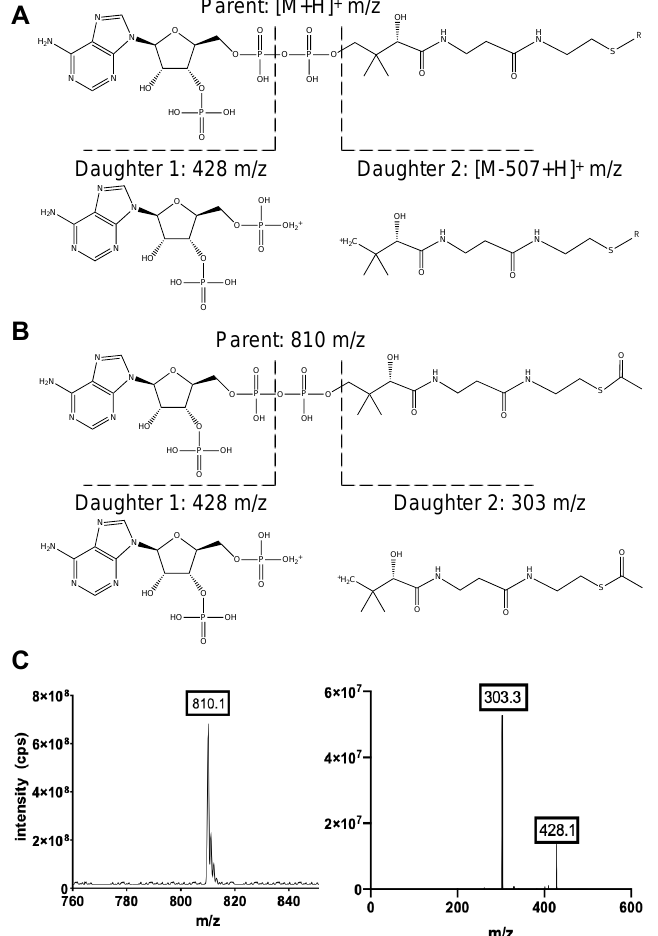
Figure 2. The common MS/MS fragmentation pattern for all CoA species: ( A ) The CoA portion of all CoA esters fragments during MS/MS at the 3 (cid:48) -phosphate-adenosine-5 (cid:48) -diphosphate. This cleavage gave rise to a daughter ion equal to [M − 507 + H] + m/z (right). “M” is the molecular mass of the starting compound. The phosphate-adenosine portion also fragments between the 5 (cid:48) -diphosphates and gave rise to a daughter equal to 428 m/z (left). ( B ) Acetyl CoA has a parent m/z of 810 with a predicted fragmentation pattern for daughter ions of 428 m/z and 303 m/z. ( C ) The MS1 parent and predicted MS2 daughter ions for acetyl CoA were detected following direct infusion of 1 µ g/mL acetyl CoA into the mass